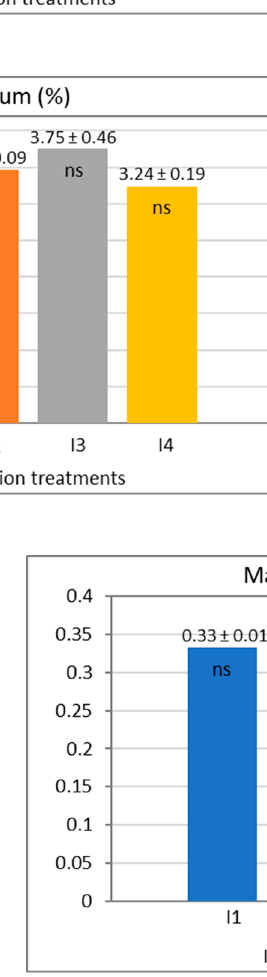
Figure 2. Concentrations of N, P, K, Ca and Mg in tomato leaves cultivated under different irrigation treatments; * mean ± standard deviation; ns = data in bars with the same letters are not significantly different at p > 0.5 according to Tukey’s